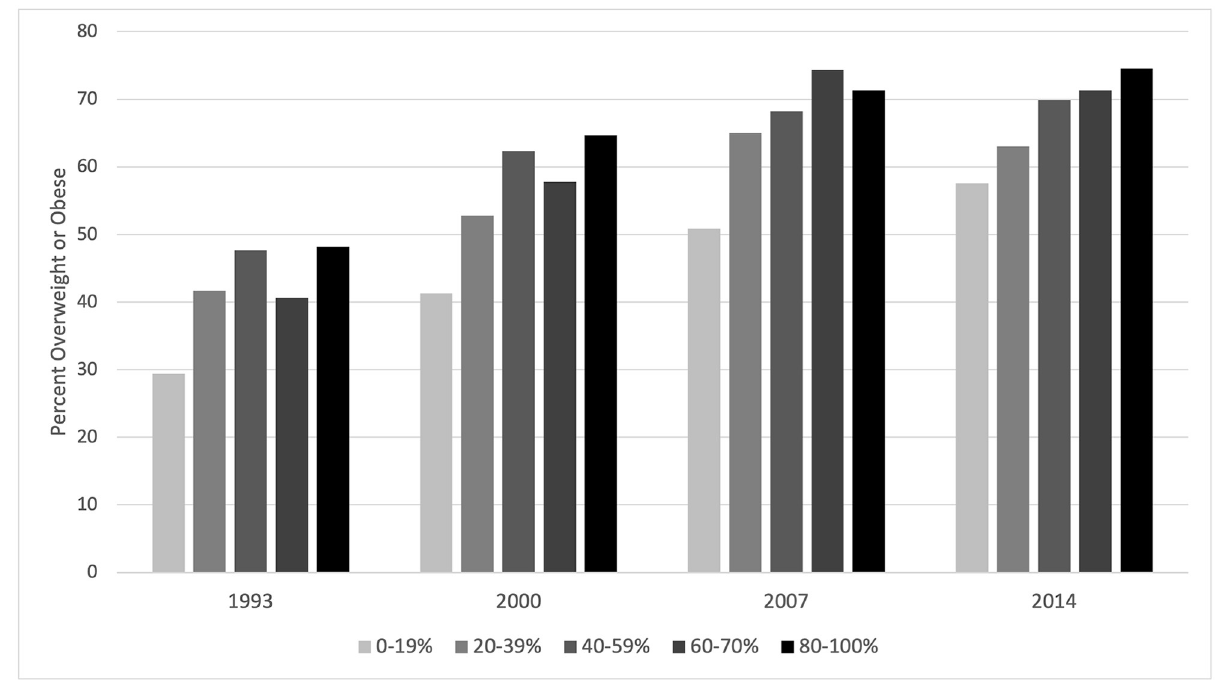
Fig 5. Proportion overweight and obese by built-up categories, IFLS